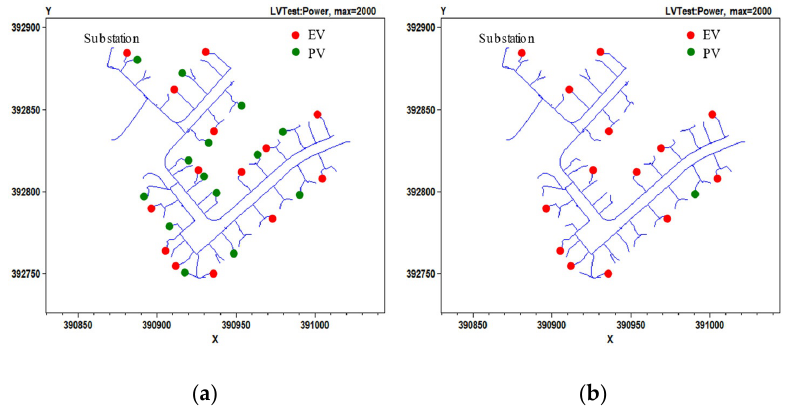
Figure 10. Test cases: ( a ) distributed EV and PV ( b ) distributed EV single PV.